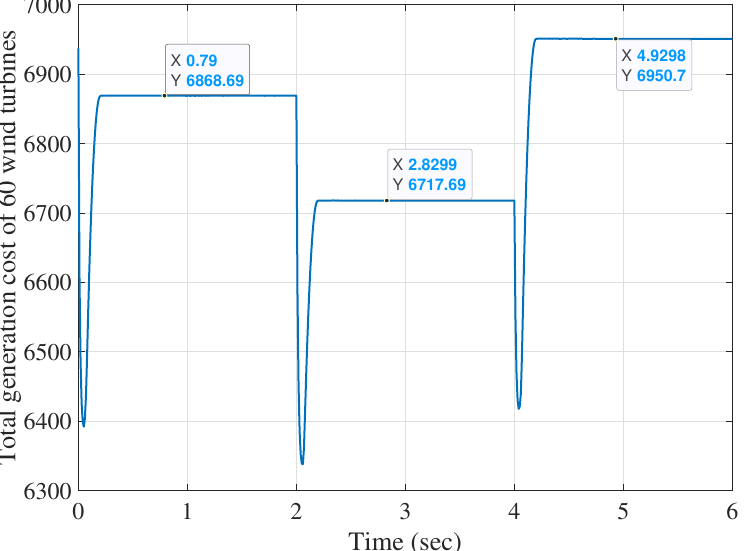
Figure 4. Variation curve of total generation cost of 60 wind turbines in Princess Amalia wind